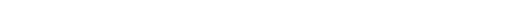
Fig. 7. Bone microstructure in subadult ceratopsian dinosaur Psittacosaurus lujiatunensis Zhou, Gao, Fox, and Chen, 2006 from western Liaoning, China, Early Cretaceous. The outer cortex of mid-diaphyseal transverse section of right humerus (IVPP V12617, A ), right radius (IVPP V12617, C ), right tibia (IVPP V12617, D ). The inner most cortex of mid-diaphyseal transverse section of right humerus (IVPP V12617, B ), right tibia (IVPP V12617, E ). Mid-diaphyseal transverse section of fibula (IVPP V18343, F ). Photographs in regular transmitted light (A 1 –F 1 ), elliptically polarized light (A 2 –F 2 ), crossed plane-polarized light (B 3 , E 3 ); line drawings (A 3 , C 3 , D 3 , F 3 ) showing longitudinal vascular canals (navy), reticular vascular canals (green), radial vascular canals (red), and LAGs (brown